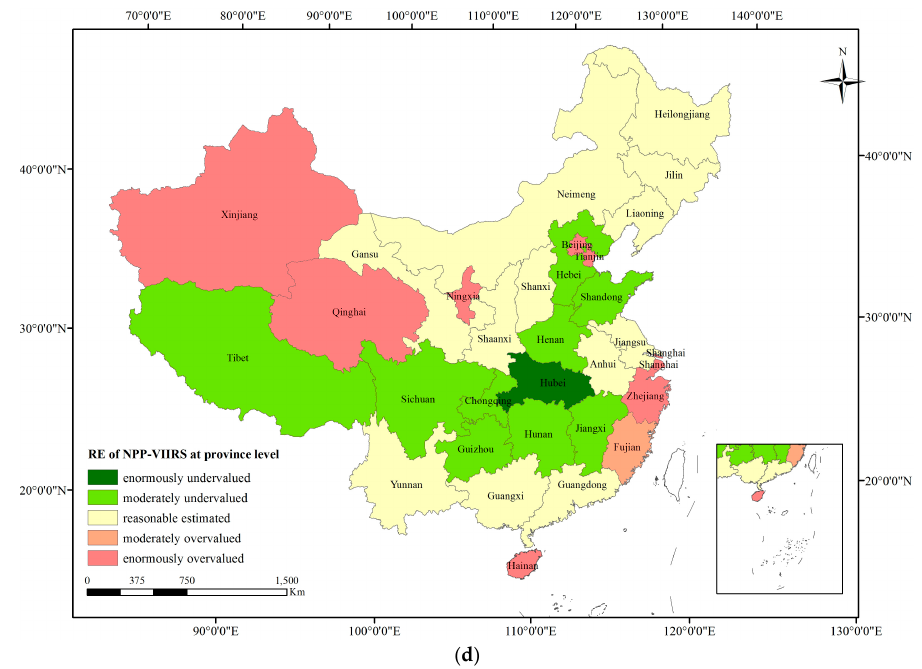
Figure 2. The Relative Errors (REs) of DMSP-OLS and NPP-VIIRS at province level: ( a , c ) The underestimated and overestimated regions for DMSP-OLS and NPP-VIIRS respectively; and ( b , d ) The spatial distributions of RE across the five classes for DMSP-OLS and NPP-VIIRS, respectively.